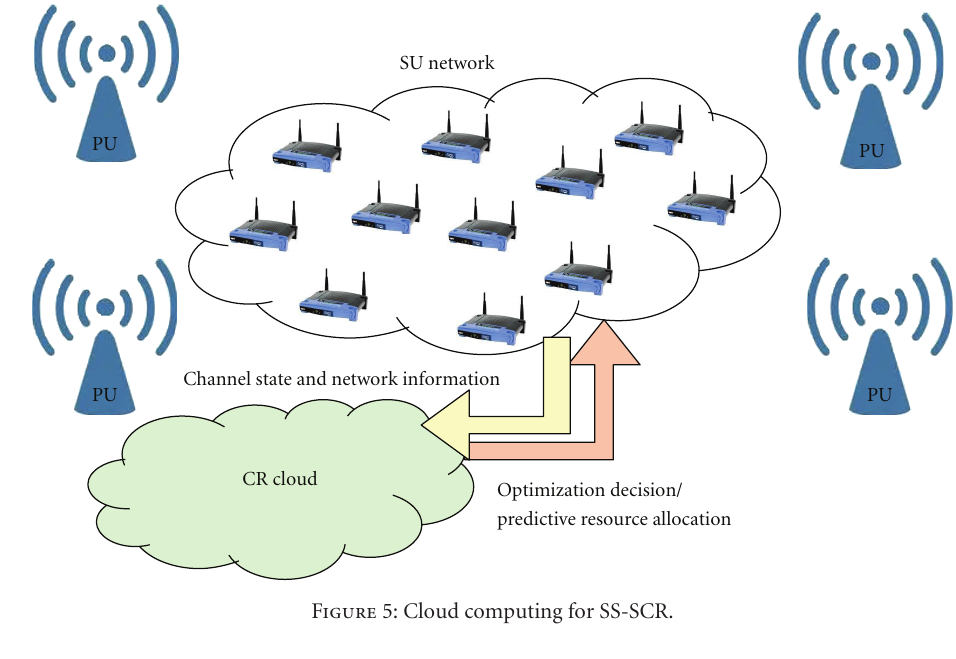
Figure 5: Cloud computing for SS-SCR.